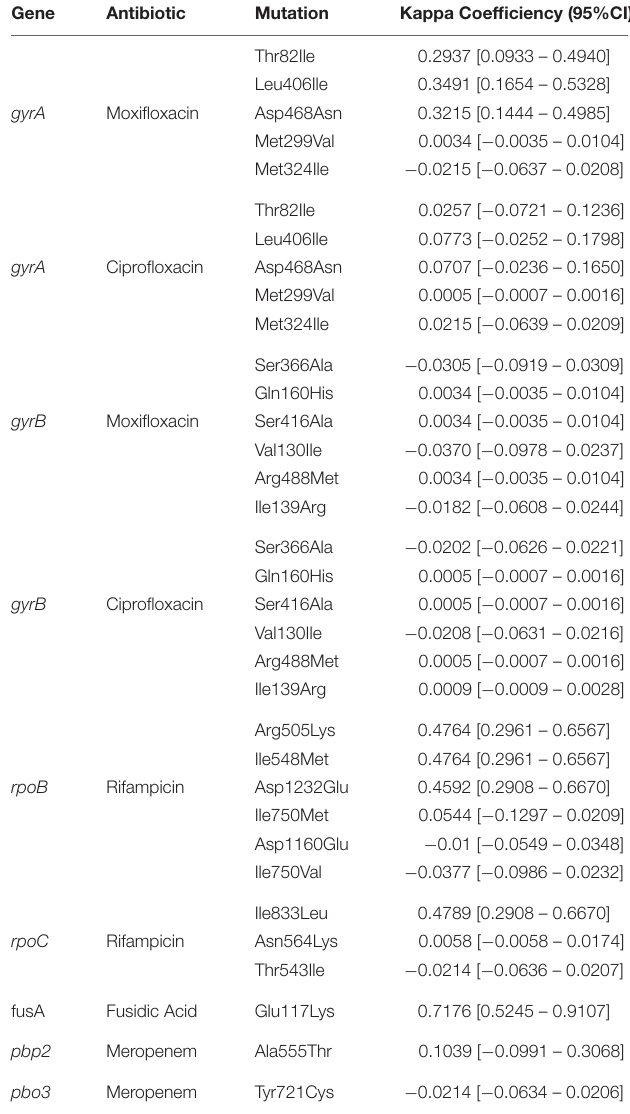
TABLE 2 | Concordance between genotypic and phenotypic drug resistance.